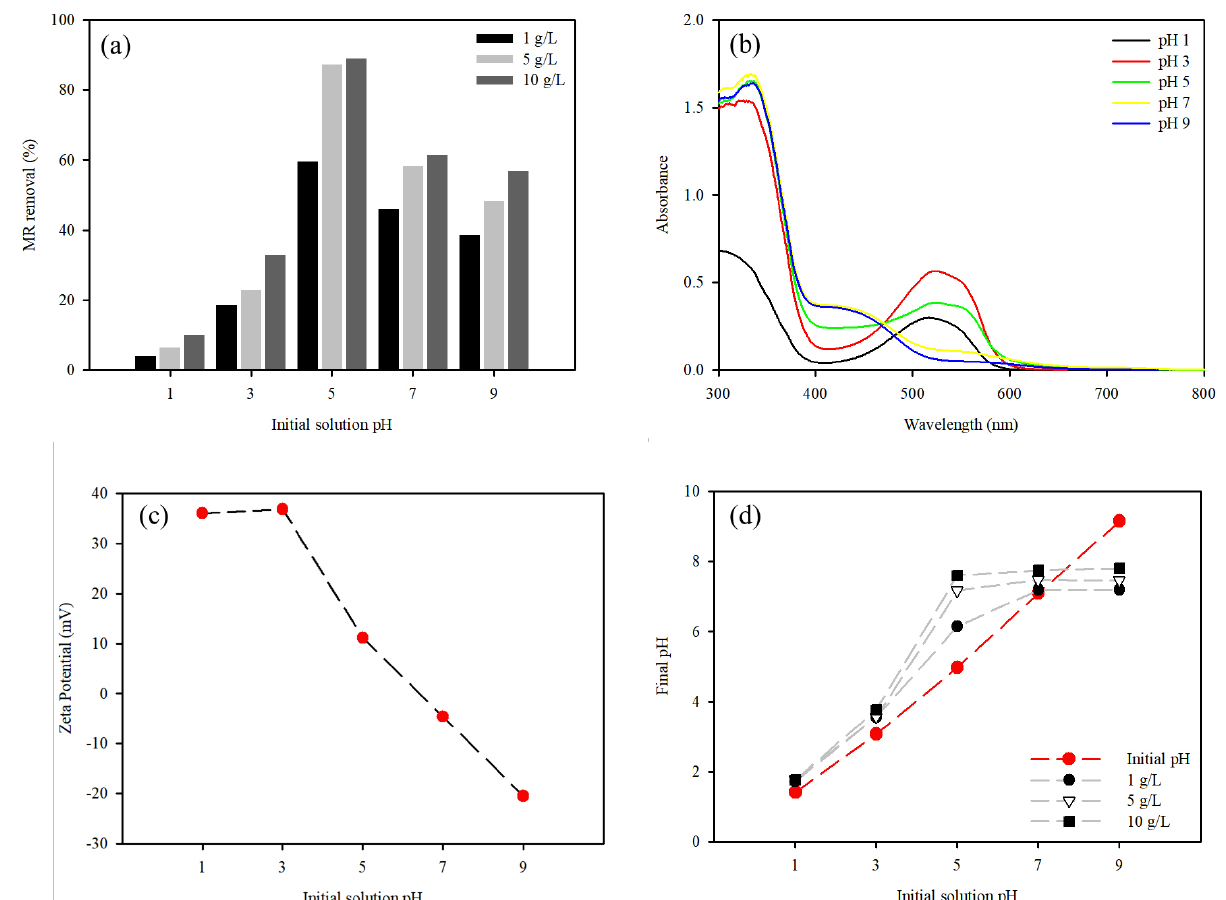
Figure 9. ( a ) MR adsorption to WFD/SA-PEI bead at solution pH ranging from 1 to 9. ( b ) UV-Vis spectrum of MR at various pH values. ( c ) Zeta potential of the WFD/SA-PEI bead as a function of solution pH. ( d ) Effect of the initial pH on the final pH of the solution reacted with the WFD/SA-PEI bead. The characteristic peaks of the initial solution pH of the MR are shown in Figure